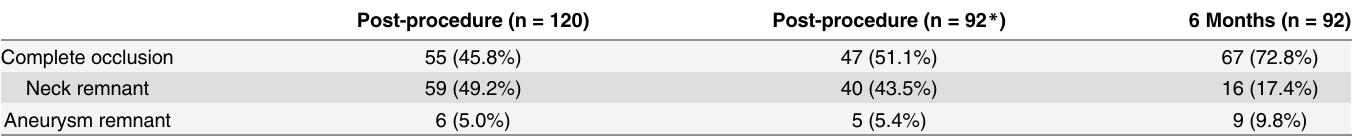
Table 2. Results of post-procedural occlusion and occlusion at six months.